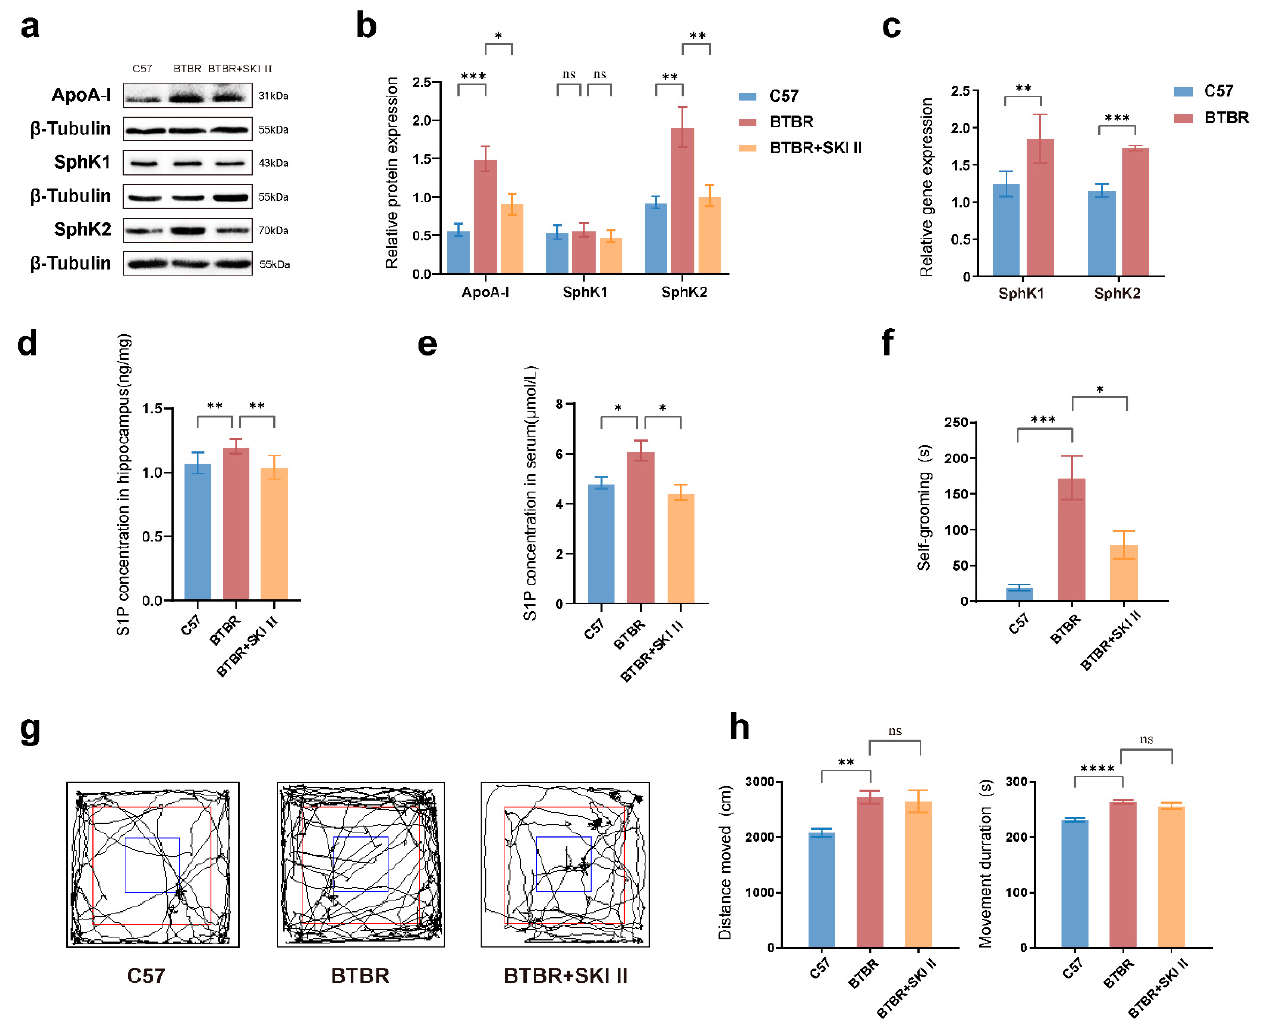
Figure 5. Examination of ApoA-I and its downstream molecule SphK-S1P expression and ASD behavioral phenotypes in BTBR mice before and after SKI II intervention. ( a , b ) Representative Western blotting bands and quantification of the ApoA-I/ β -tubulin, SphK1/ β -tubulin, SphK2/ β -tubulin ratios in the ApoA-I pathway. ( c ) RT-qPCR quantification mRNA expression of SphK1 and SphK2. ( d , e ) S1P levels in the serum and hippocampus before and after SKI II intervention. ( f ) Time spent self-grooming before and after SKI II intervention. ( g , h ) Representative roadmap and quantification of distance moved and movement duration before and after SKI II intervention in the open field test. N = 8–12 per group. All data are shown in bar diagrams, which reflect the arithmetic mean ± standard error of the mean. * p < 0.05, ** p < 0.01, *** p < 0.001, **** p < 0.0001.